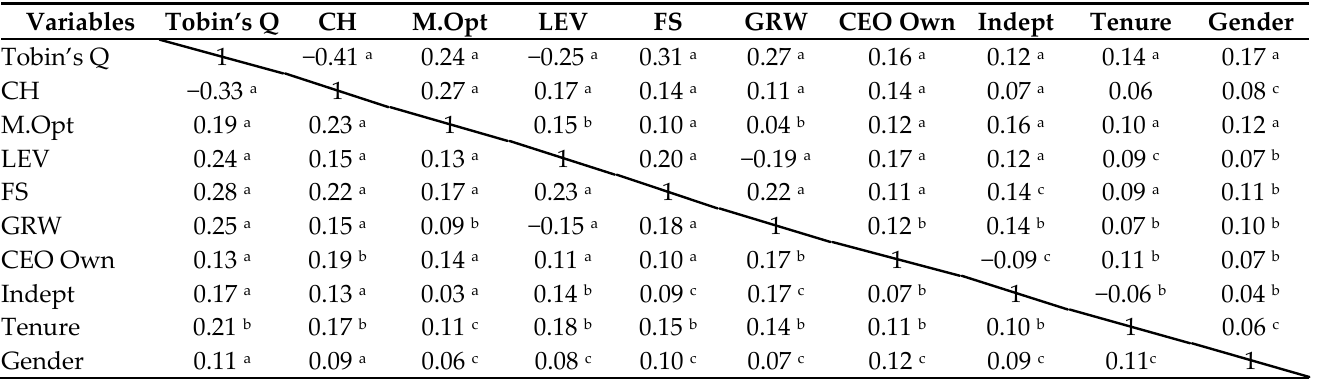
Table 6. Correlation matrix of the financially absolutely constrained and relatively constrained firms.